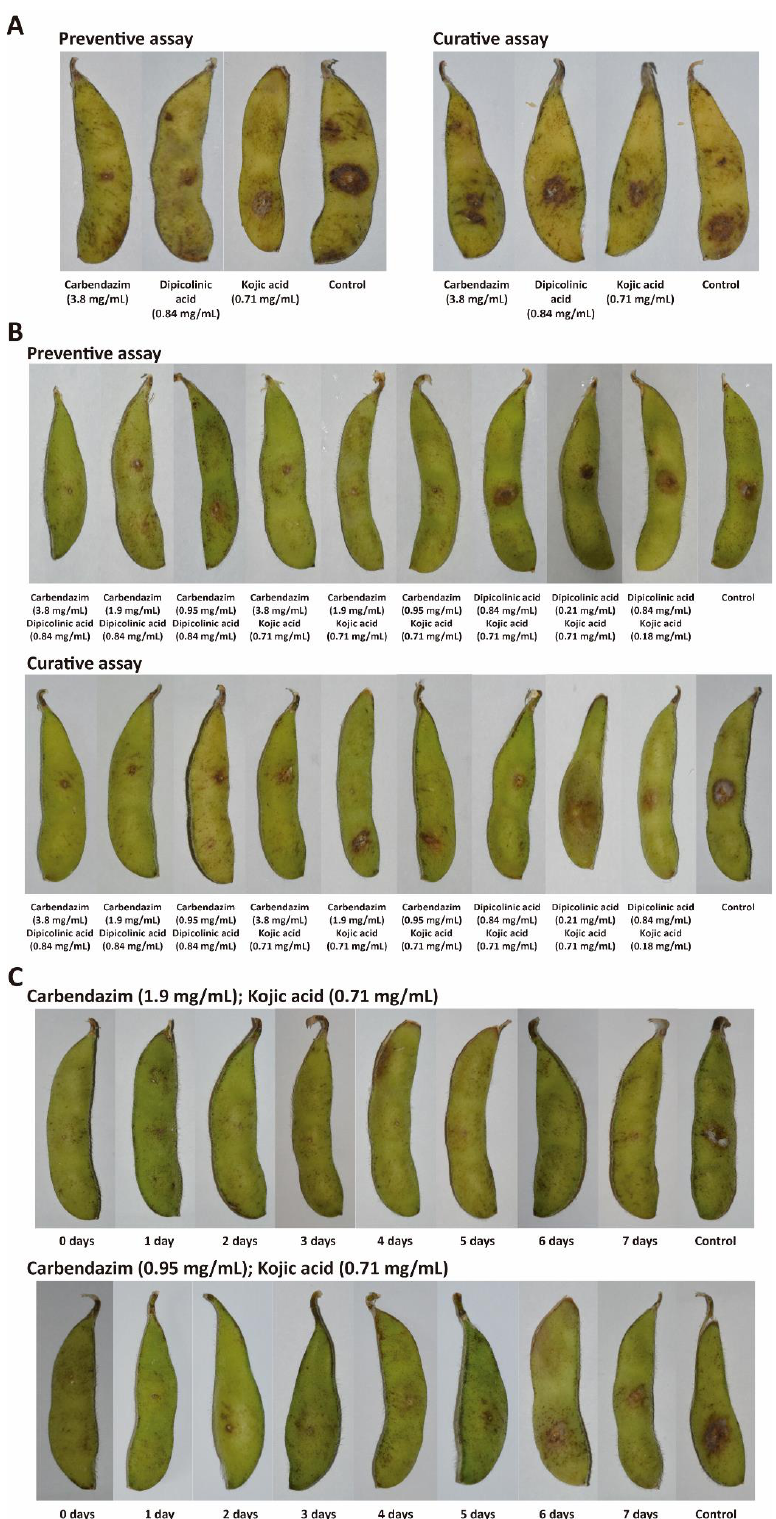
Figure 6. Images showing the efficacy of carbendazim, dipicolinic acid and kojic acid for the control of Fusarium sulawense NJC31 symptoms on soybean pods. ( A ) Symptoms after treatment with carbendazim, dipicolinic acid and kojic acid separately. ( B ) Symptoms after applying combinations of carbendazim, dipicolinic acid and kojic acid. ( C ) Symptoms after preventive application with carbendazim and kojic acid. The pathogen was inoculated at different time points after treatment with the fungicides. Control experiments were carried out in the absence of